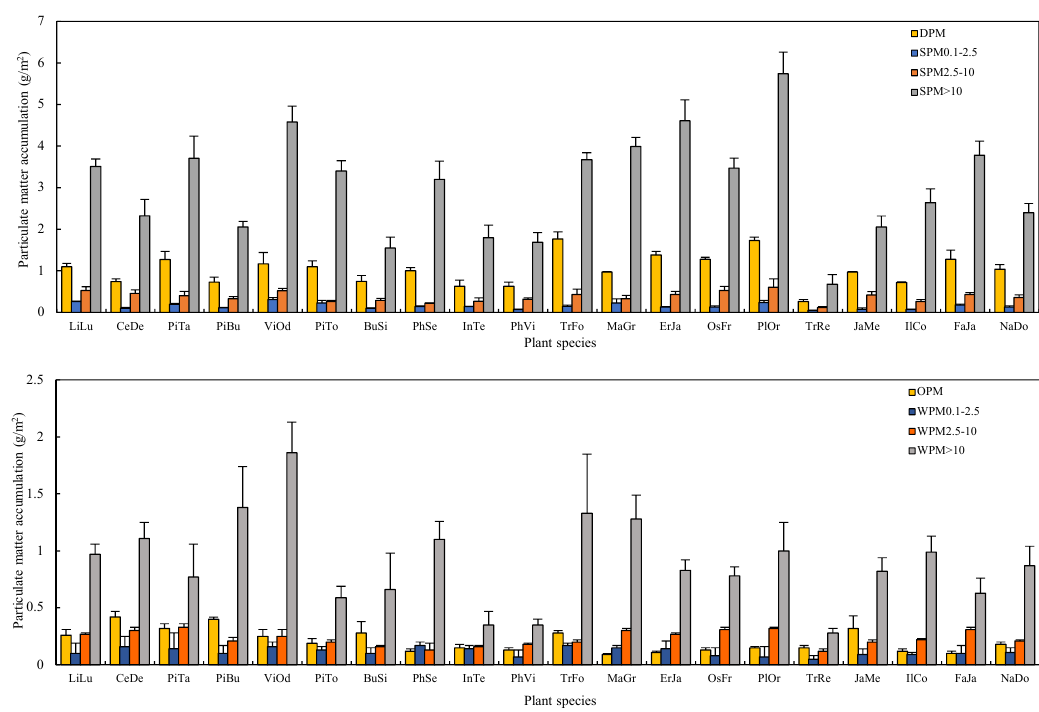
Figure 3. The mass of PM per unit leaf area eluted by water and brushing (SPM), chloroform and brushing (WPM) within different diameter classes (diameter > 10 µ m, 2.5-10 µ m, 0.1-2.5 µ m), water-soluble (DPM), and organic-soluble (OPM) particulate matter retained on the investigated leaves.